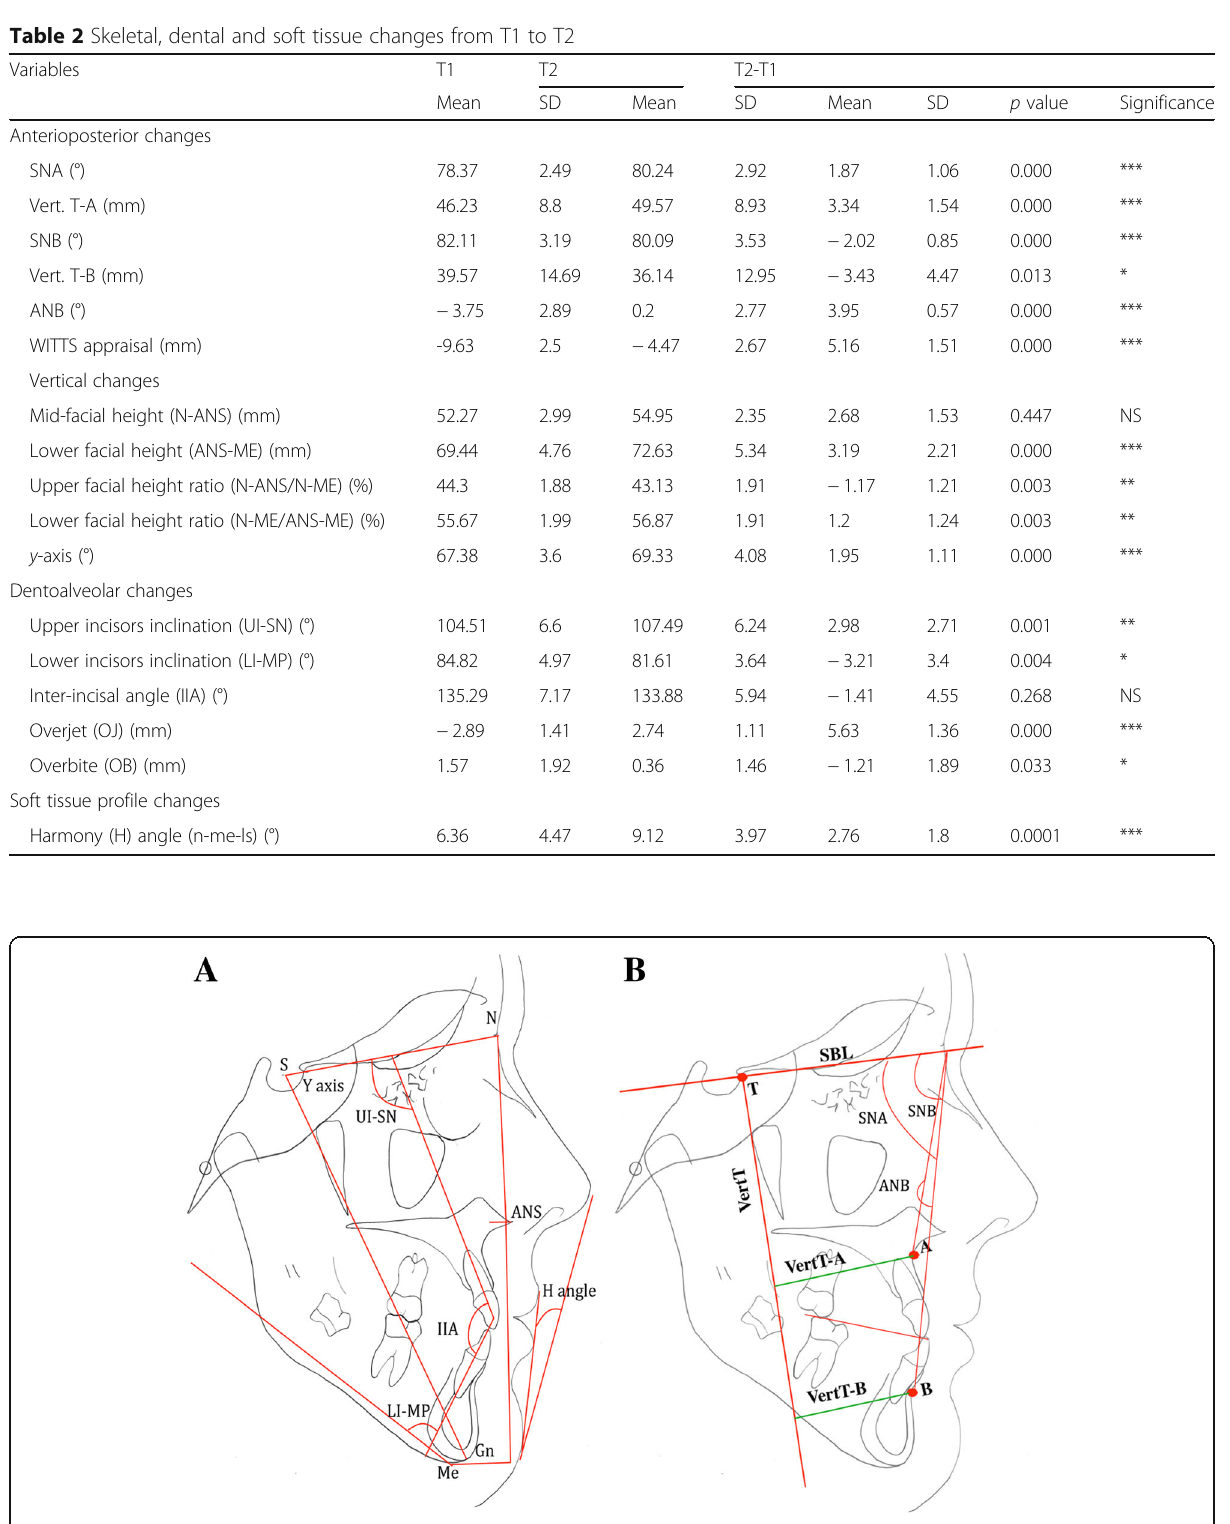
Fig. 4 a , b Cephalometric variables used to evaluate the skeletal, dental, and soft tissue changes from T1 to T2 (SNA (°), Vert. T-A (mm), SNB (°) Vert. T-B (mm), ANB (°), WITTS appraisal (mm), mid-facial height (N-ANS) (mm), lower facial height (ANS-ME) (mm), upper facial height ratio (N- ANS/N-ME) (%), lower facial height ratio (N-ME/ANS-ME) (%), y -axis (°), upper incisors inclination (UI-SN) (°), lower incisors inclination (LI-MP) (°), inter-incisal angle (IIA) (°), overjet (OJ) (mm), overbite (OB) (mm), harmony (H), angle (n-me-ls)